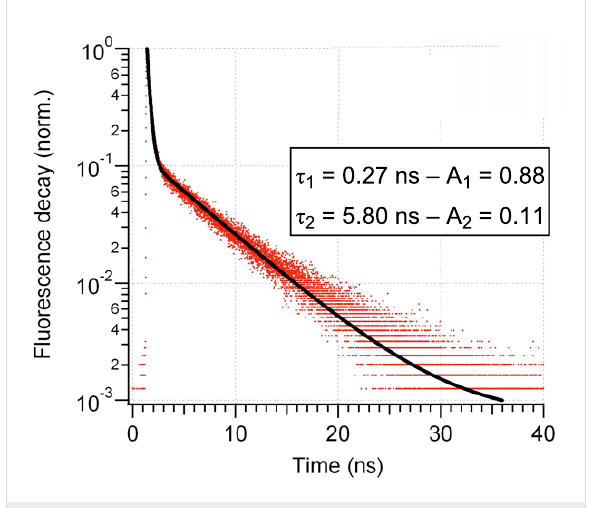
Figure 4: Fluorescence decay profile of 4 from a 10 − 5 M solution in ethanol (excitation at 450 nm, detection at 550